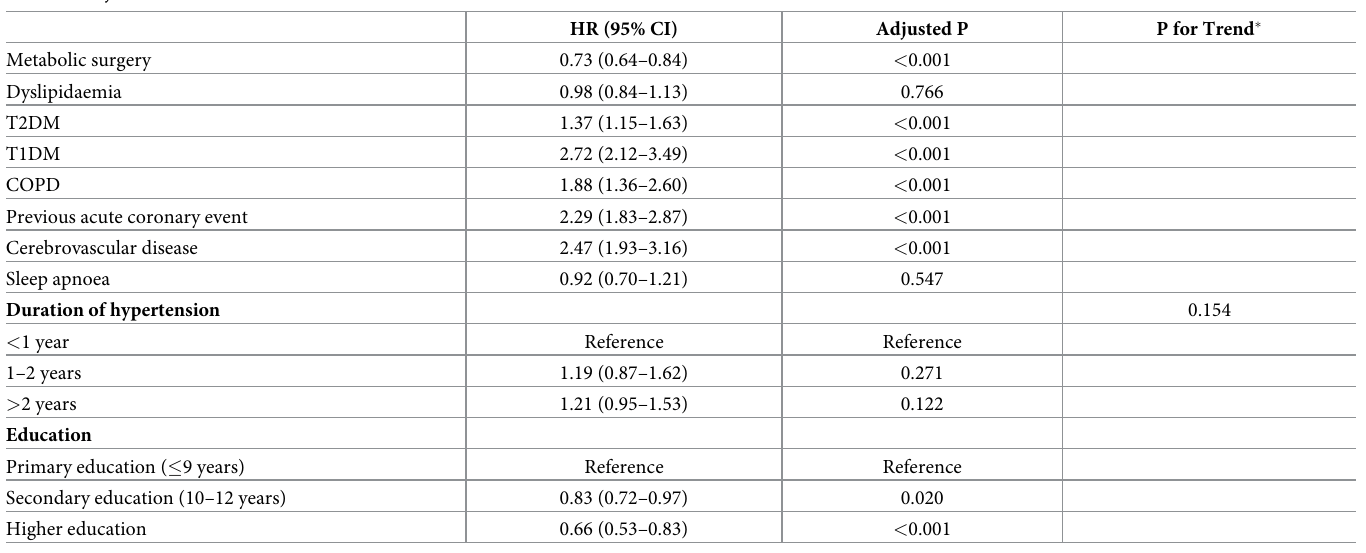
Table 2. Adjusted risk for